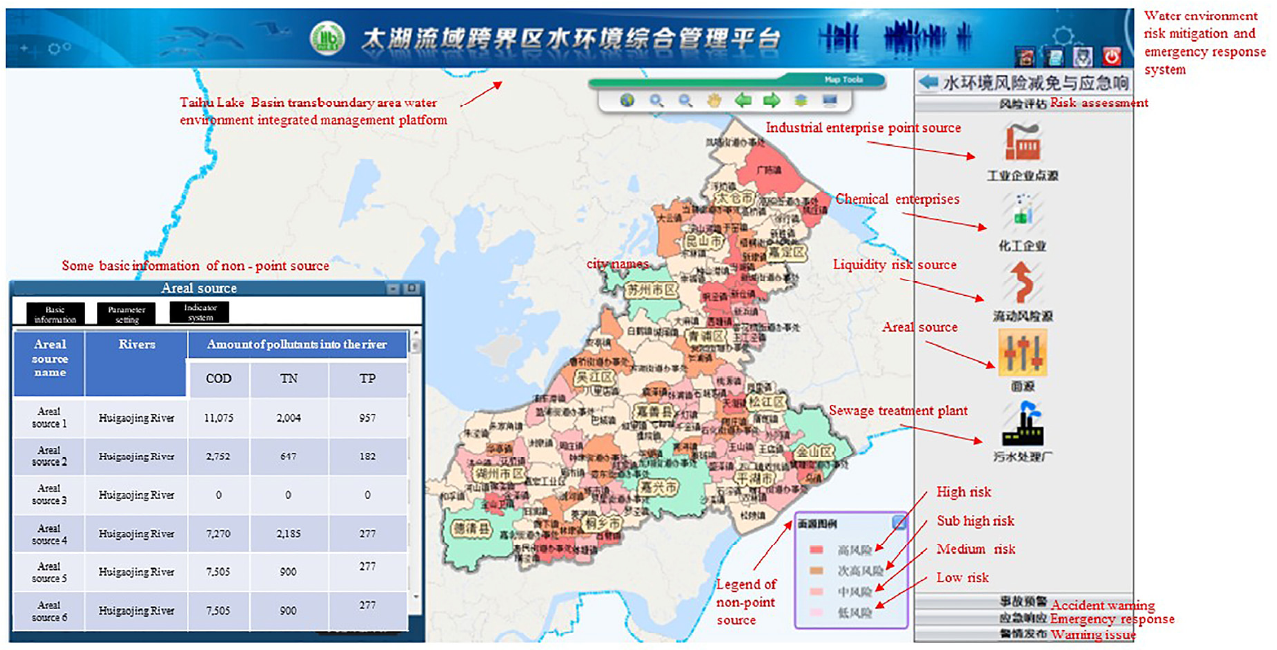
Figure 8. Non-point source risk assessment results.